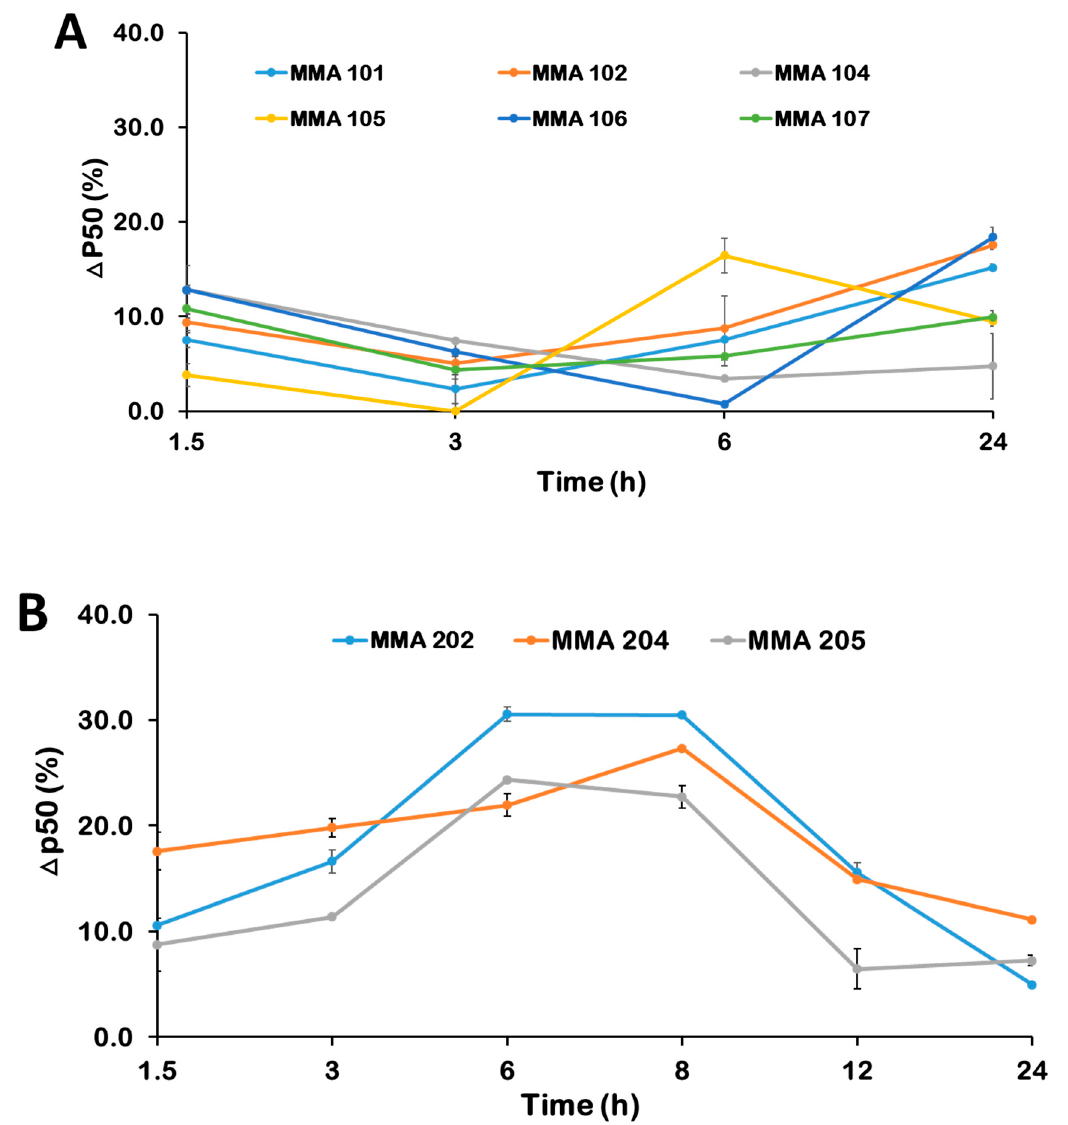
Figure 3. Time-dependent P 50 -shift of HbA in normal blood (30% hematocrit) incubated with 2 mM test compound. ( A ) Effect of MMA-100 series of compounds on Hb affinity for oxygen. ( B ) Effect of MMA-200 series of compounds on Hb affinity for oxygen.